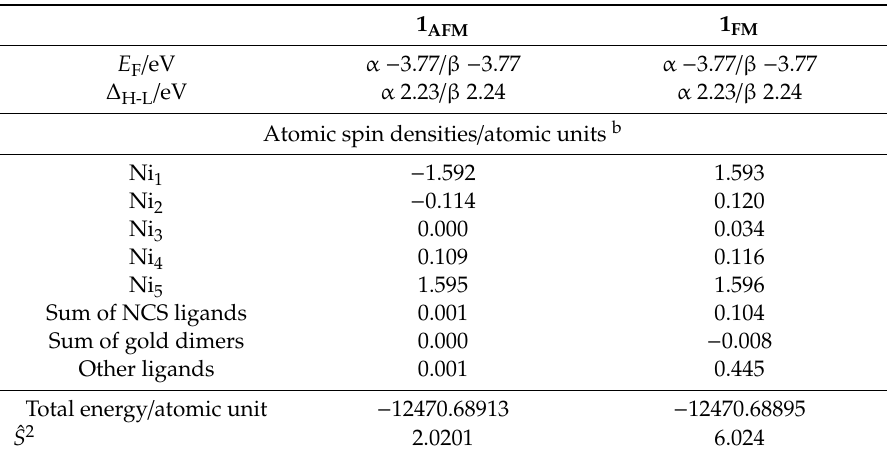
Table 1. Summary of calculated values for 1 AFM and 1 FM. a